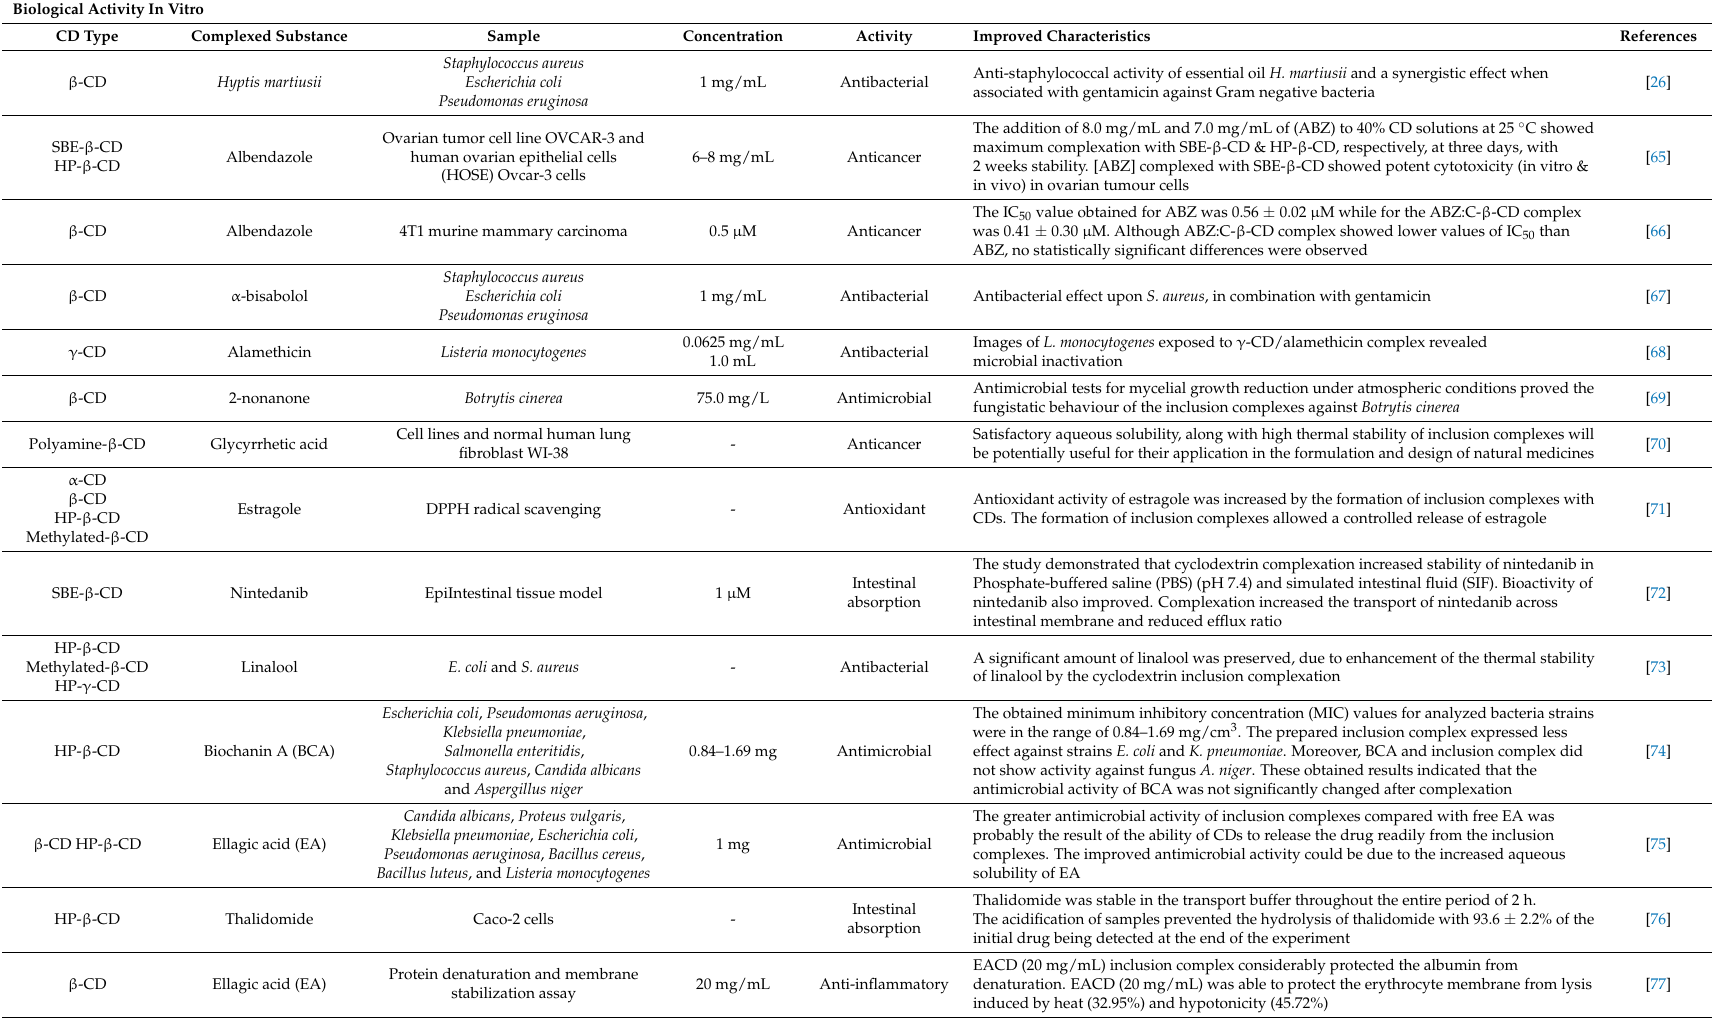
Table 2. In vitro studies of cyclodextrin inclusion